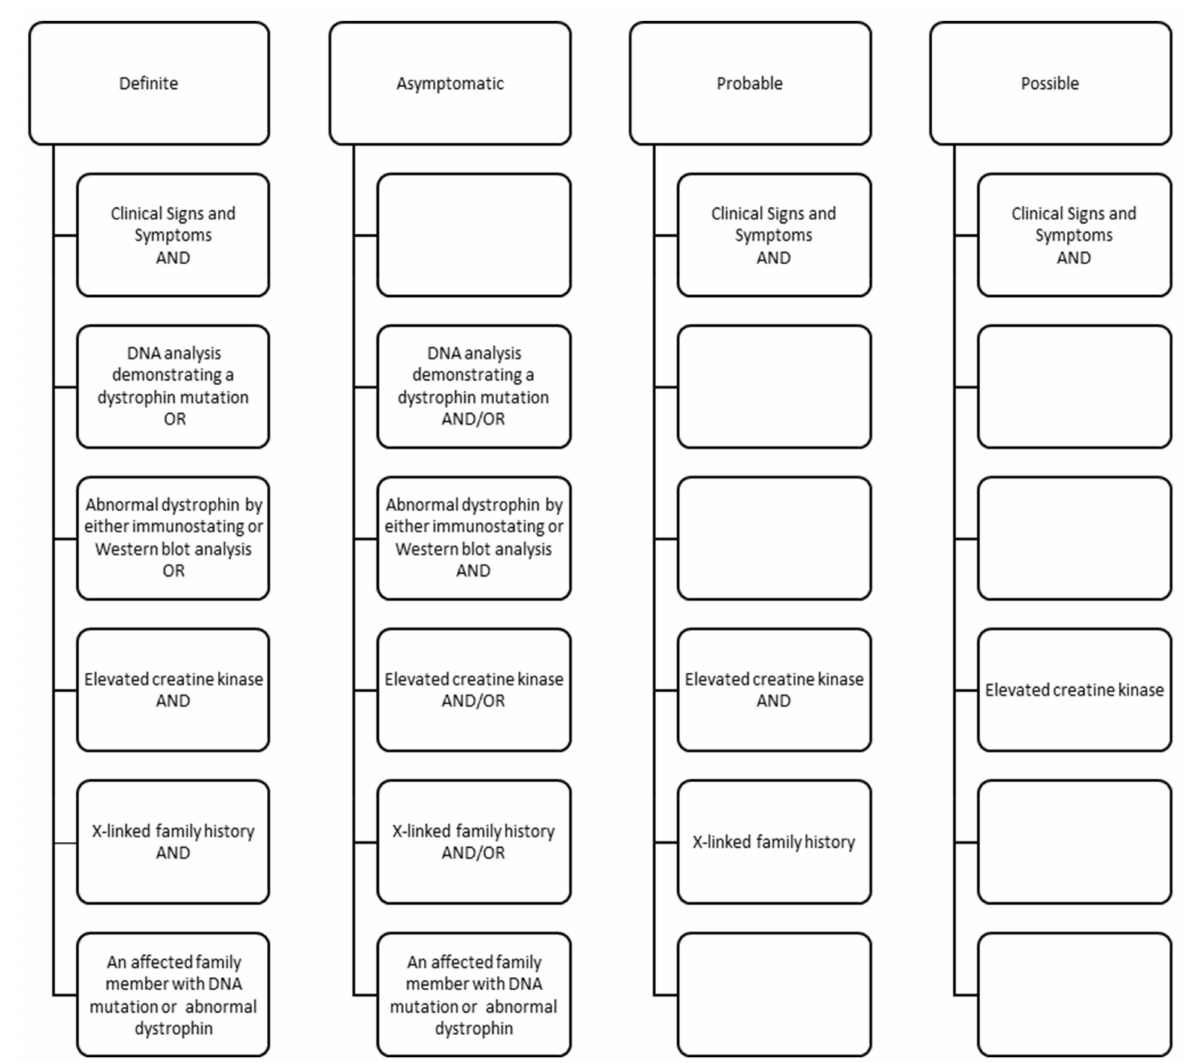
Figure 1. Clinical components for classification of males with Duchenne or Becker muscular dystrophy in the Muscular Dystrophy Surveillance, Tracking and Research Network (MD STAR net ), 2000–2015. Classifications defined as: definite– clinical signs plus direct confirmation (pathogenic DMD mutation, decreased amount or size of dystrophin, or X-linked family history and elevated creatine kinase); asymptomatic–pathogenic DMD mutation but no clinical signs; probable– clinical signs plus elevated creatine kinase and X-linked family history; possible–clinical signs plus elevated creatine kinase, but no family